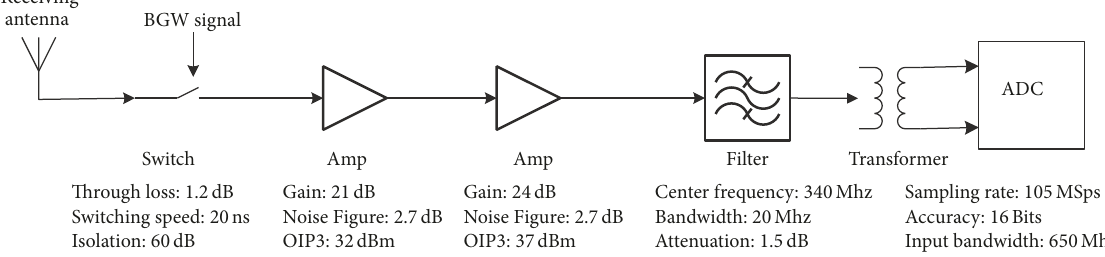
Figure 2: AFE and ADC